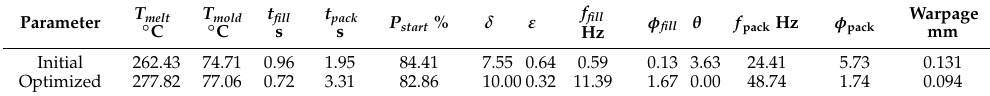
Table 13. Dynamic parameters and warpage results of the PC/ABS phone cover.